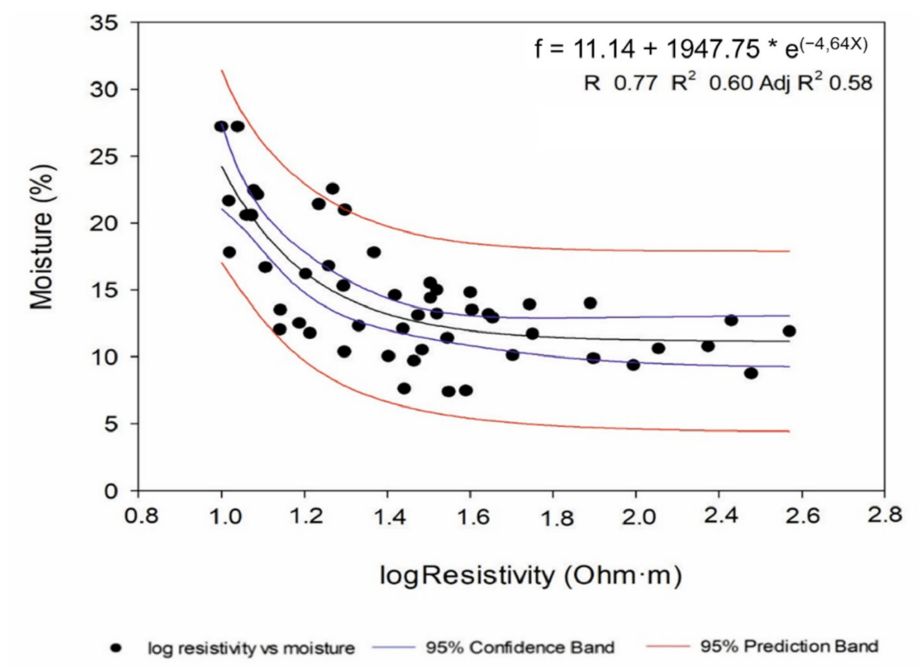
Figure 4. Calibrated model (exponential decay of a three-parameter equation) for soil moisture estimation using the logarithm of electrical resistivity as the explanatory variable ( n =